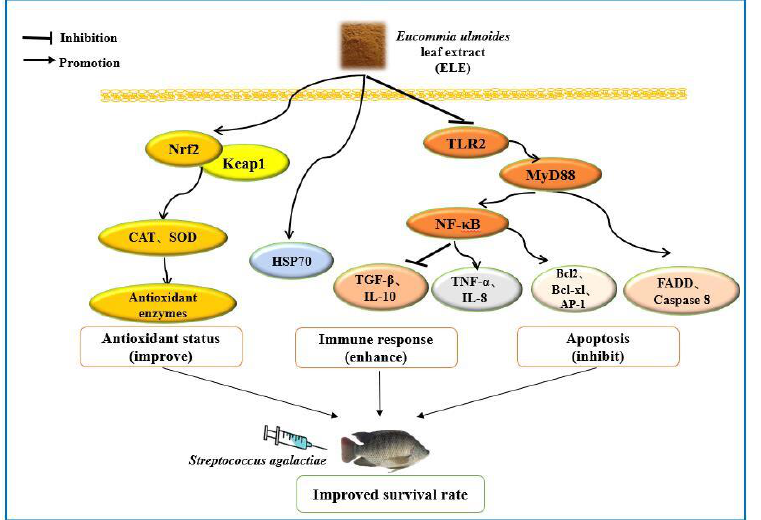
Figure 7. Regulation mechanism of improving health status by Eucommia ulmoides leaf extract (ELE) in GIFT.